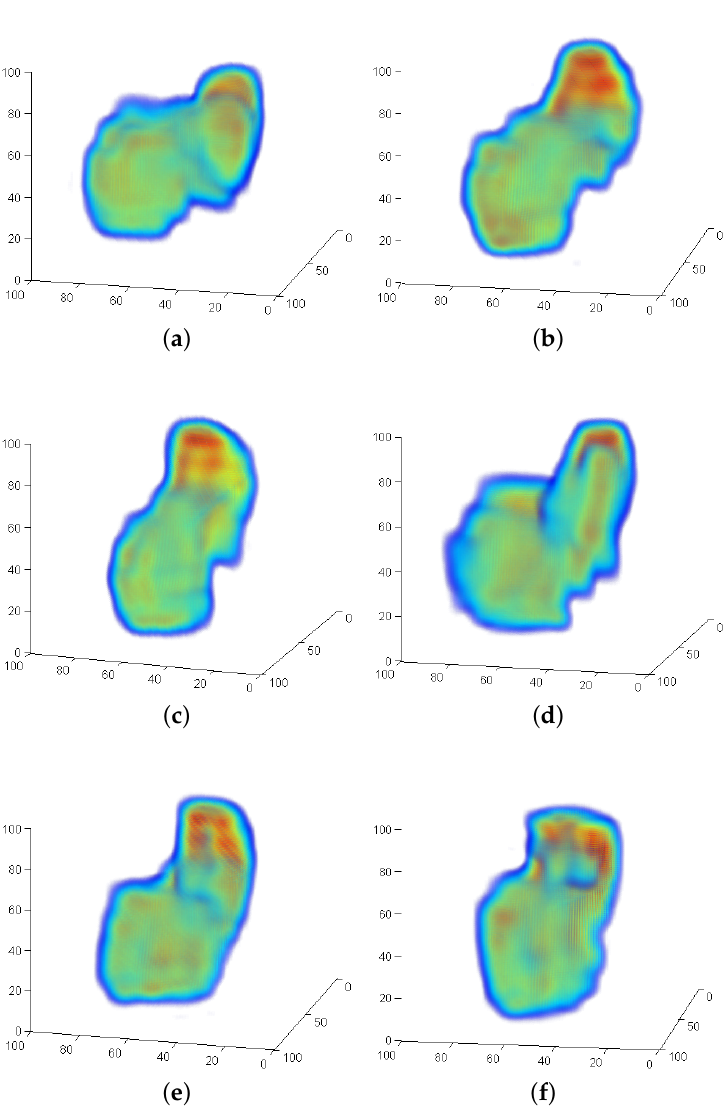
Figure 13. Sequence B2 bones. Comparison of two different person with different hand positions. The changing shape shows a significant tilt within the movement of the B1 bone. ( a ) Person 1, B2, left position. ( b ) Person 1, B2, center position. ( c ) Person 1, B2, right position. ( d ) Person 2, B2, left position. ( e ) Person 2, B2, center position. ( f ) Person 2, B2, right